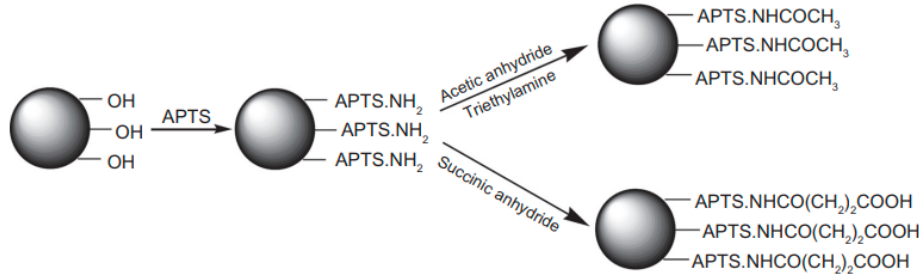
Figure 13. Schematic representation of reactions to modify nHA through 3-aminopropyltriethoxysilane (APTES)-mediated functionalization. Reprinted from Ref. [81] with copyright permission (2011) from Dove Medical Press Ltd. The cytotoxicity of APTES-modified nHA was assayed by 2,5-diphenyl-2H-tetrazolium bromide (MTT) test in which yellow-colored 3-(4,5-dimethyl thiazol-2-yl)-2,5-diphenyl-tetrazolium bromide was reduced to pur- ple-colored formazan by mitochondria reductase of seeded live L929 cells. The produced formazan was quantitively determined by recording optical density (597 nm), which was